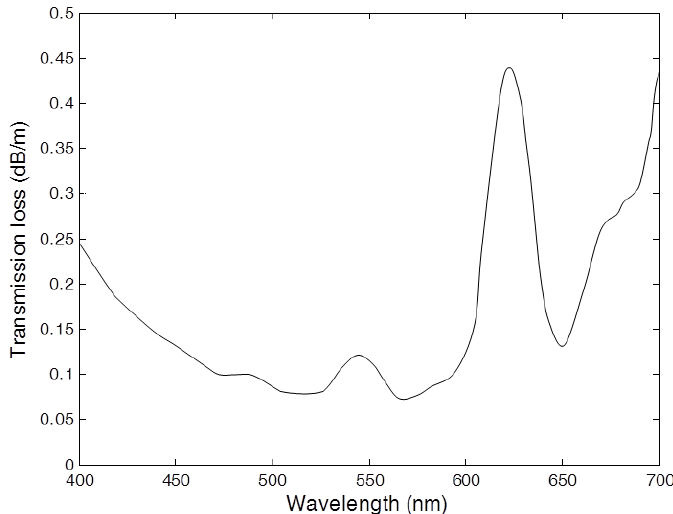
Figure 1. Transmission characteristic of the PMMA based optical fiber.